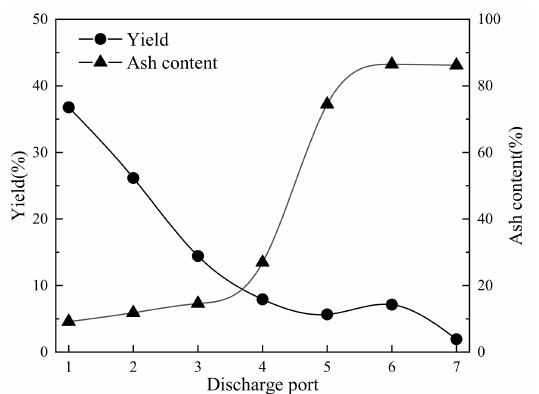
Figure 12. Curves of product yield and ash content under optimal separation